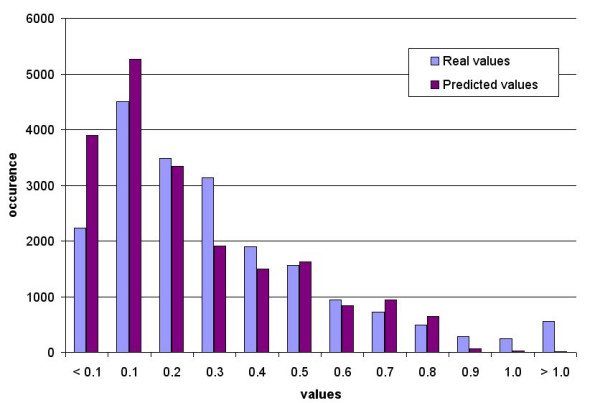
Comparison of real and kNN predicted values distribution. Histograms of the real values of the OS (1/7) (black bars) and the predicted values using kNN method with kopt = 14 (grey bars) are shown. The values are shown in absolute value. All the values superior to 1.0 (respectively inferior to 0.1) have been pooled in the '> 1.0' group (respectively '< 0.1').